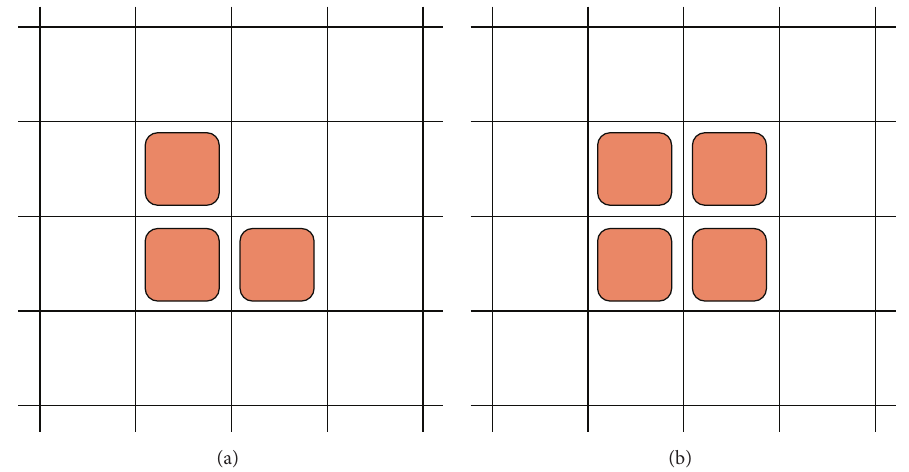
Figure 10: (a) Compact placement of three units. (b) Compact placement of four